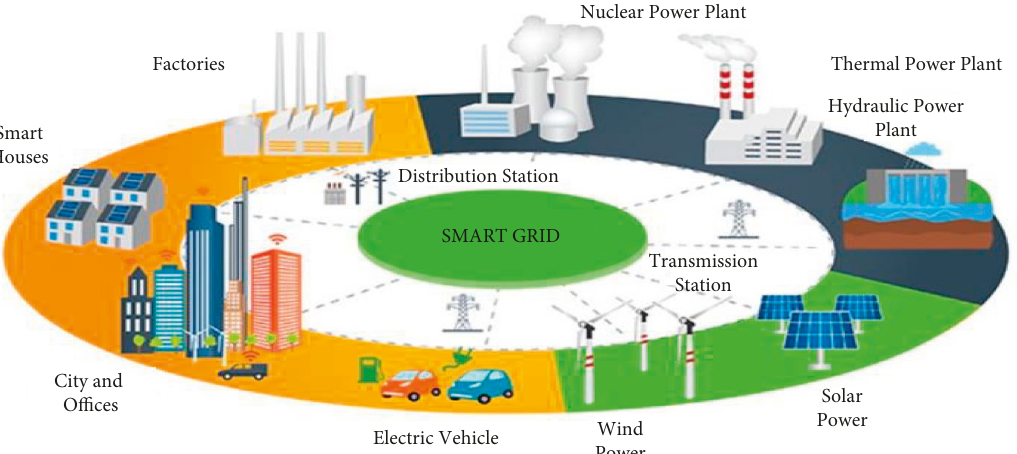
Figure 1: Smart grid. Source: Smart grid evolution, 2018. Eolas Magazine. URL: https://www.eolasmagazine.ie/smart-grid-evolution/ (accessed 2.18.22).